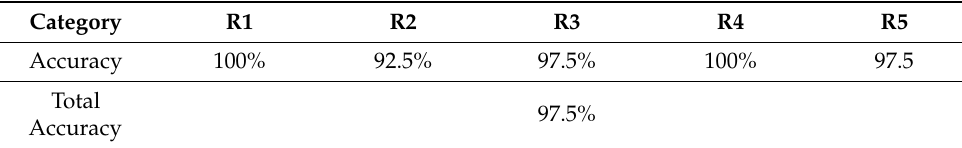
Figure 6. Comparison between predicted results and accurate values. Table 4. Test accuracies for each type of